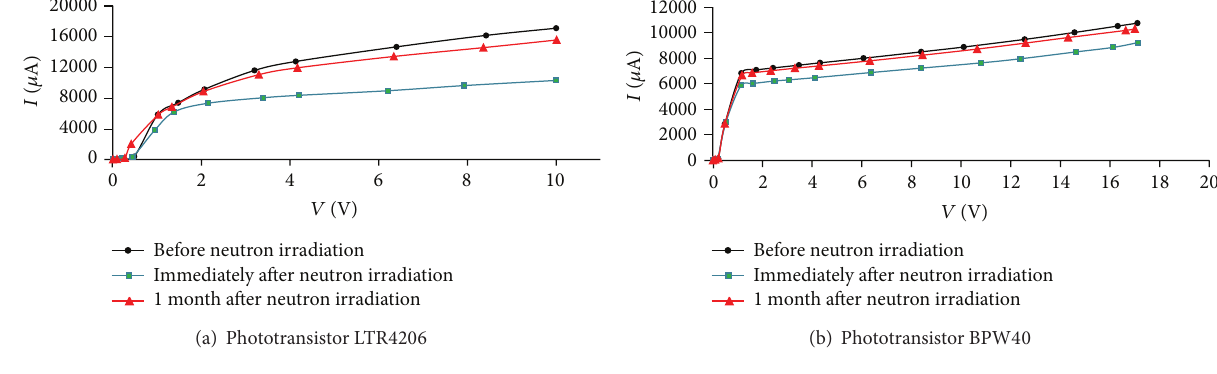
Figure 3: 𝐼 - 𝑉 characteristics of the phototransistors before and after neutron